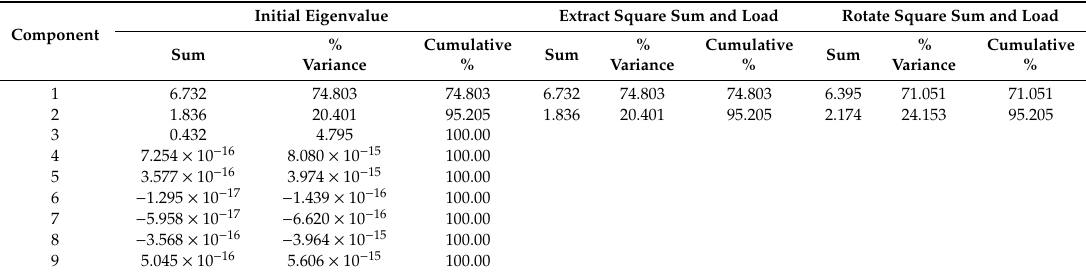
Table 2. Total variance of